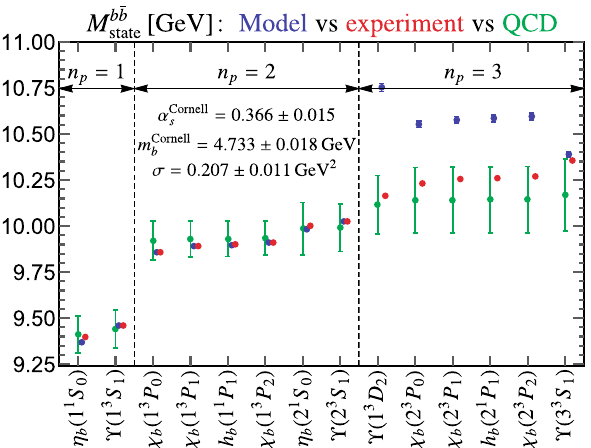
and blue correspond to n = 1, while cyan and red have n = 2. Green and cyan have (cid:6) = 0 while blue and red correspond to (cid:6) = 1. The dashed lines show the asymptotic behavior both at large and small r